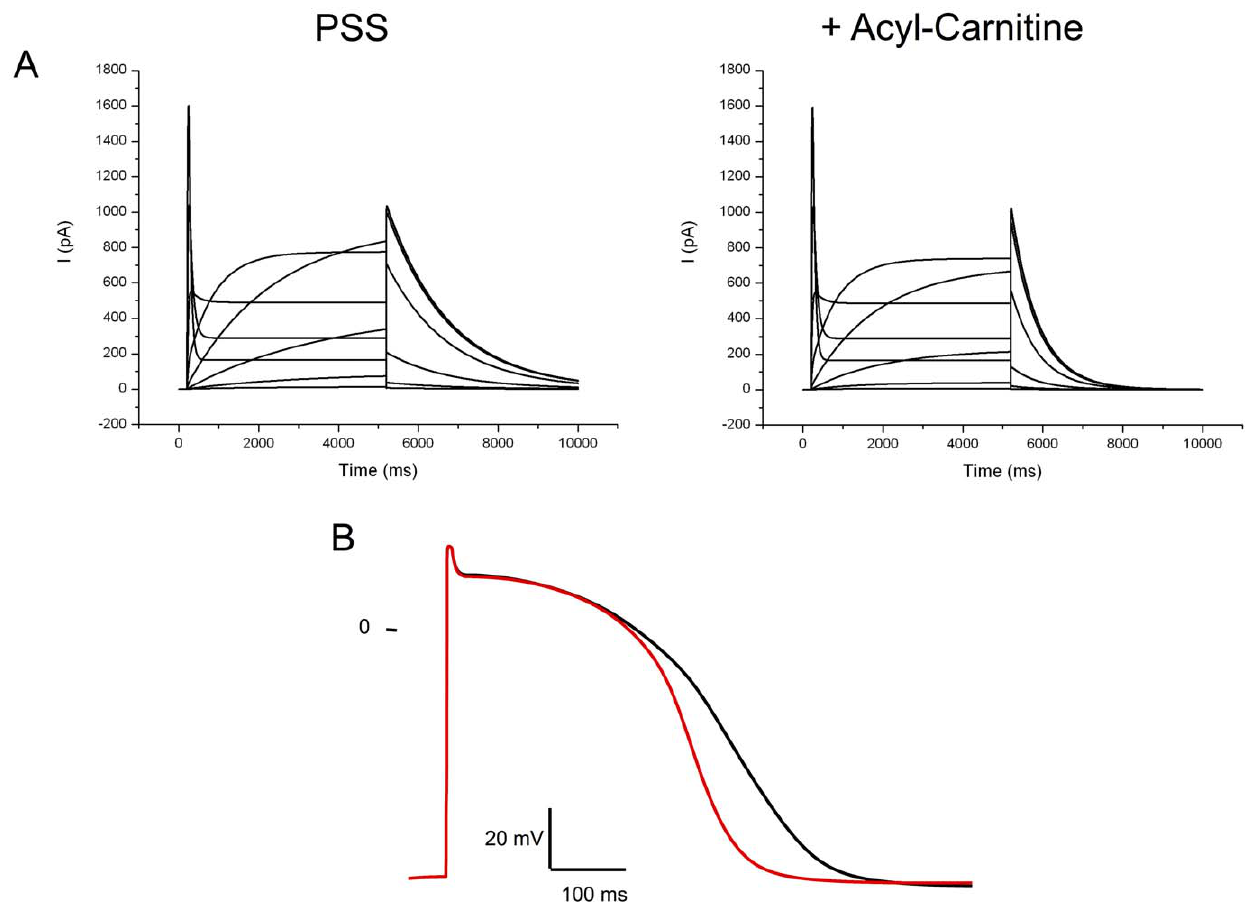
Figure 8. Computer simulation of the effects of LCAC on I KR and the human ventricular action potential. A , families of currents mimicking I KR with or without acyl-CARs. B , action potential profile in the absence of acylcarnitine(black line) or the presence of a physiological concentration of 3 m M LCAC (red line).